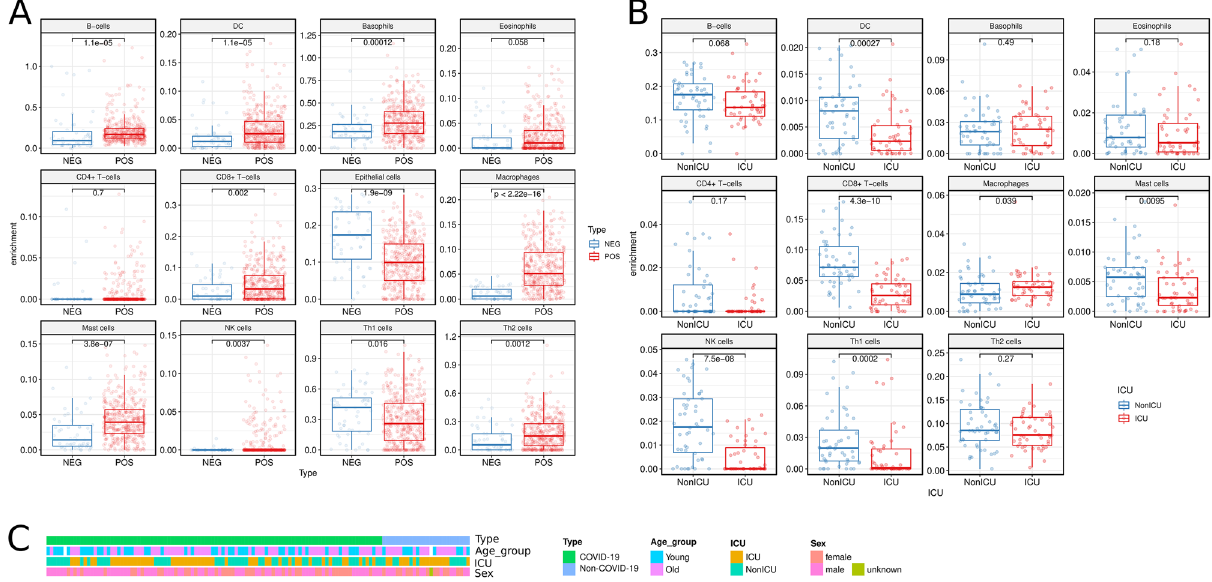
Figure 3. Comparison of immune cell infiltration based on RNA-seq data by using Immune Infiltration module. ( A ) Comparison of immune infiltration between SARS-CoV-2-positive and -negative samples in GSE152075 nasopharyngeal swabs. Most of the immune cells increased during infection. ( B ) The difference of immune infiltrating cells between the subjects entering and not entering ICU, using GSE157103 peripheral blood leukocyte samples. ( C ) The population characteristics of all subjects in the GSE157103 dataset. The age of samples was not significantly correlated with whether the samples were admitted to the ICU (chi-square test p -value = 0.087). However, compared to Figure S3 (Old vs. Young), the change in immune infiltration was in line with figure ( B